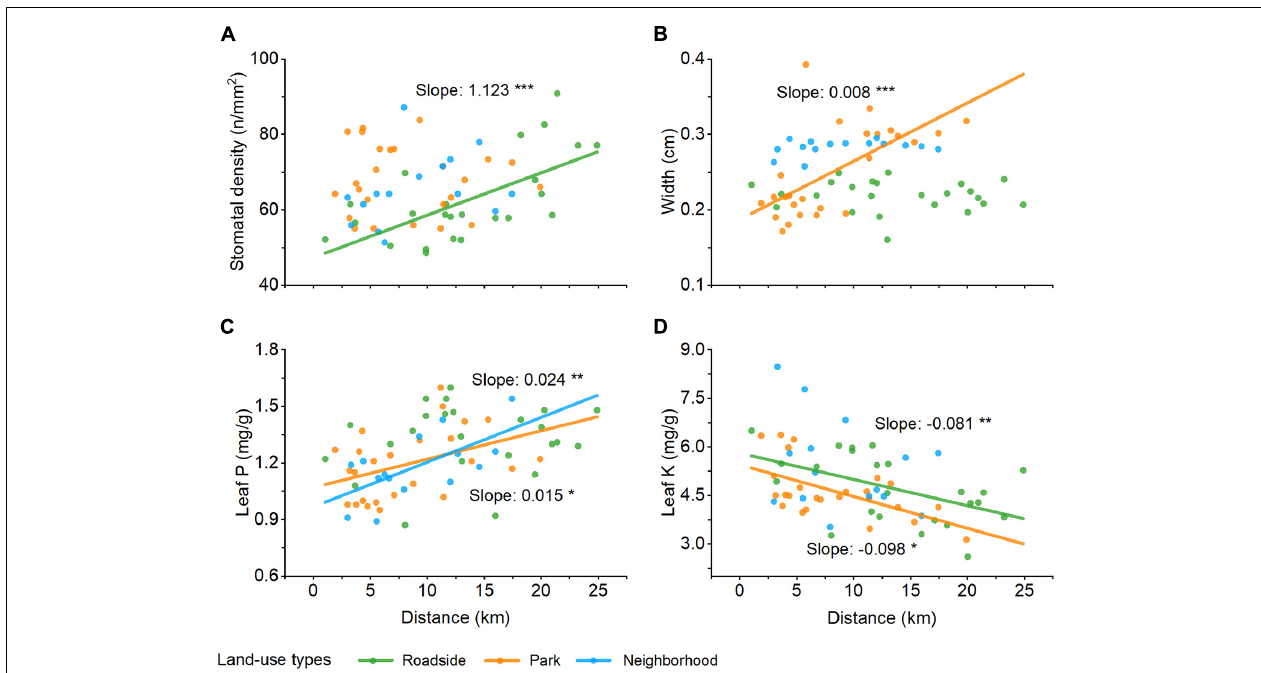
FIGURE 3 | The relationship between leaf functional traits of Chinese pine ( Pinus tabuliformis Carr.) and the distance of sites from the city center. (A) Stomatal density of current-year needles, (B) Leaf width of current-year needles, (C) Leaf P concentration of current-year needles, (D) Leaf K concentration of previous-year needles. Regression lines are shown when changes are significant. Significance level: *** p < 0.001; ** p < 0.01; * p < 0.05.